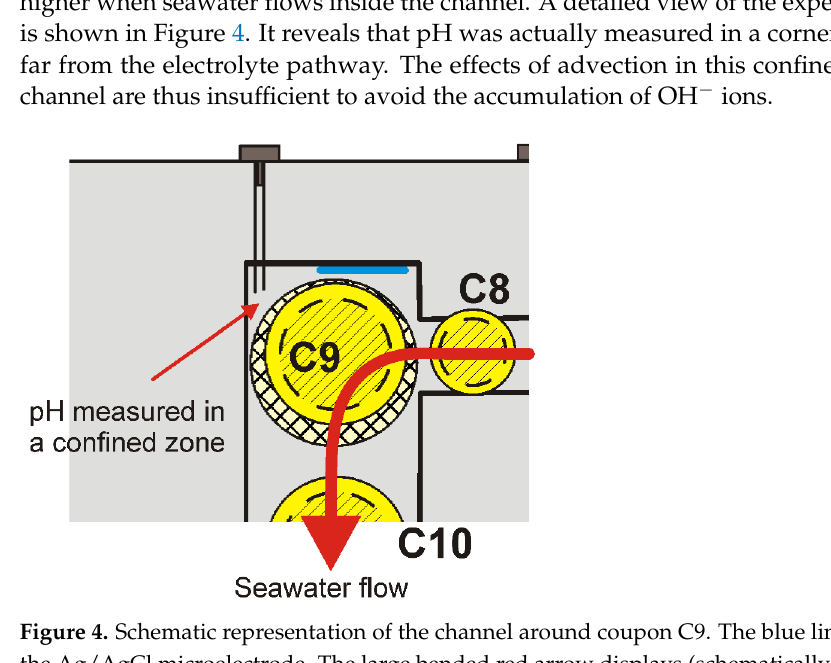
Figure 5. Evolution over time of the potential, measured with respect to the paired Ag/AgCl micro- electrode, of coupons C1, C4, C9 and C12. A measurement was also performed at the end of the experiment for coupon C6 (see Section 2.2). First, it can be seen that E IR free increases inside the channel from C1 to C12, whatever the considered time. The additional value measured for C6 at day 109 falls also between those obtained for C4 and C9, which validates the methodology used to obtain data for C6. This variation is due to the ohmic drop, which increases inside the channel as the distance from the reference electrode used to control the applied potential E app increases. Secondly, it is observed that: